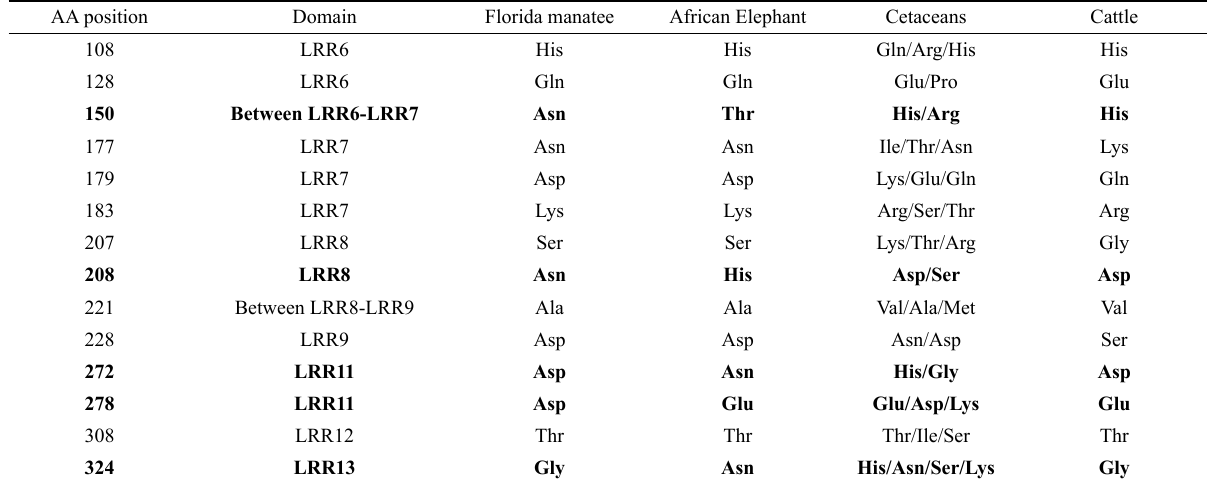
Table 1 – Positive selection at amino acid sites of cetaceans according to Shen et al. (2012) in comparison to manatee, elephant, and cattle forTLR4 using FUBAR method. In bold, amino acids that are different between Florida manatee and African elephant. AA position